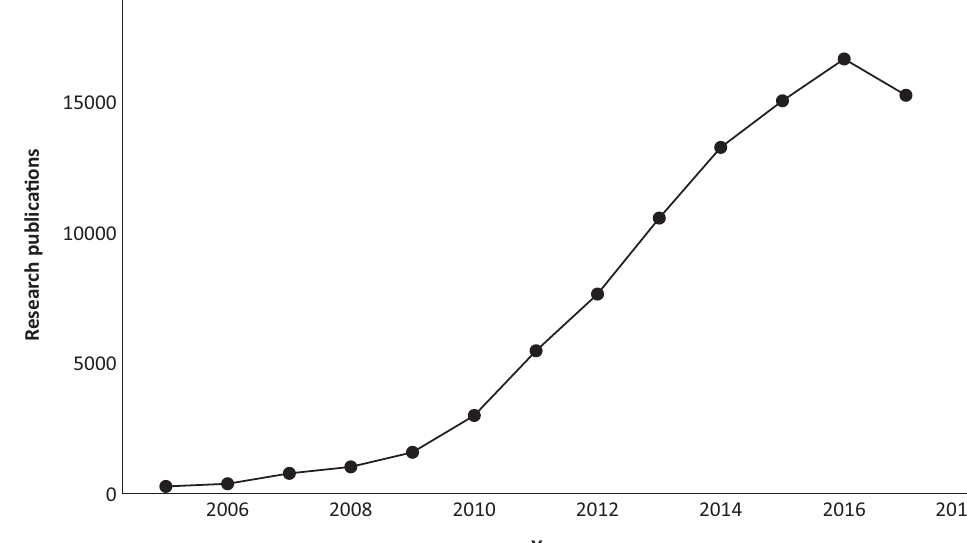
Figure 1. Number of search results for the query “‘social media’ journalism” in Google Scholar, accounting for new research publications, chapters, books, and so forth published in each of the years 2005 through